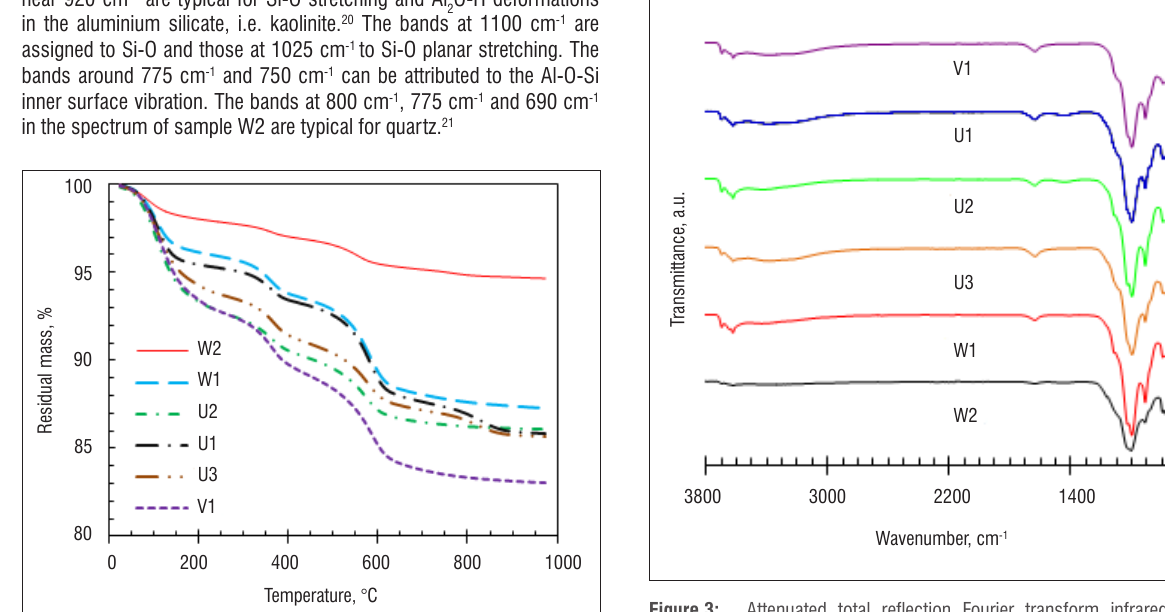
Figure 2: Thermogravimetric analysis mass loss curves for clay samples.